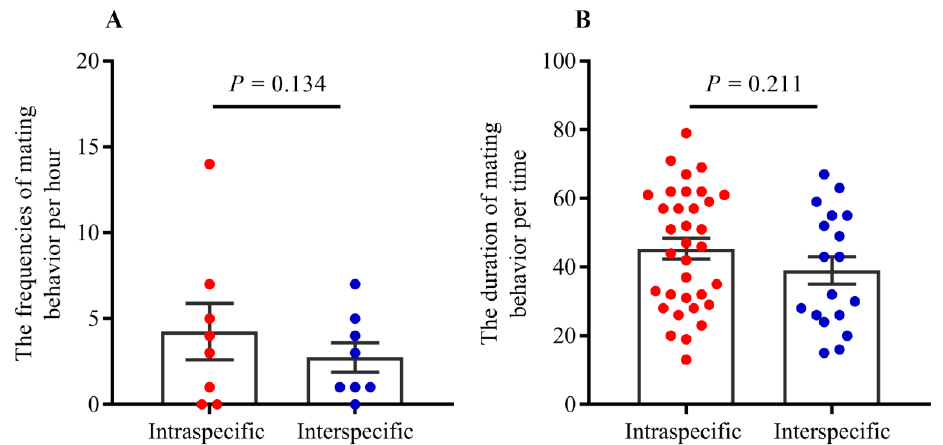
Figure 4. ( A ): The frequencies of mating in intraspecific and interspecific partners. ( B ): The duration of mating behavior per time (unit: min). There were no significant differences in mating frequencies per hour (GLMM: F = 2.53, p = 0.13) and durations ( t = 1.27, p = 0.21) between intraspecific and interspecific partners.